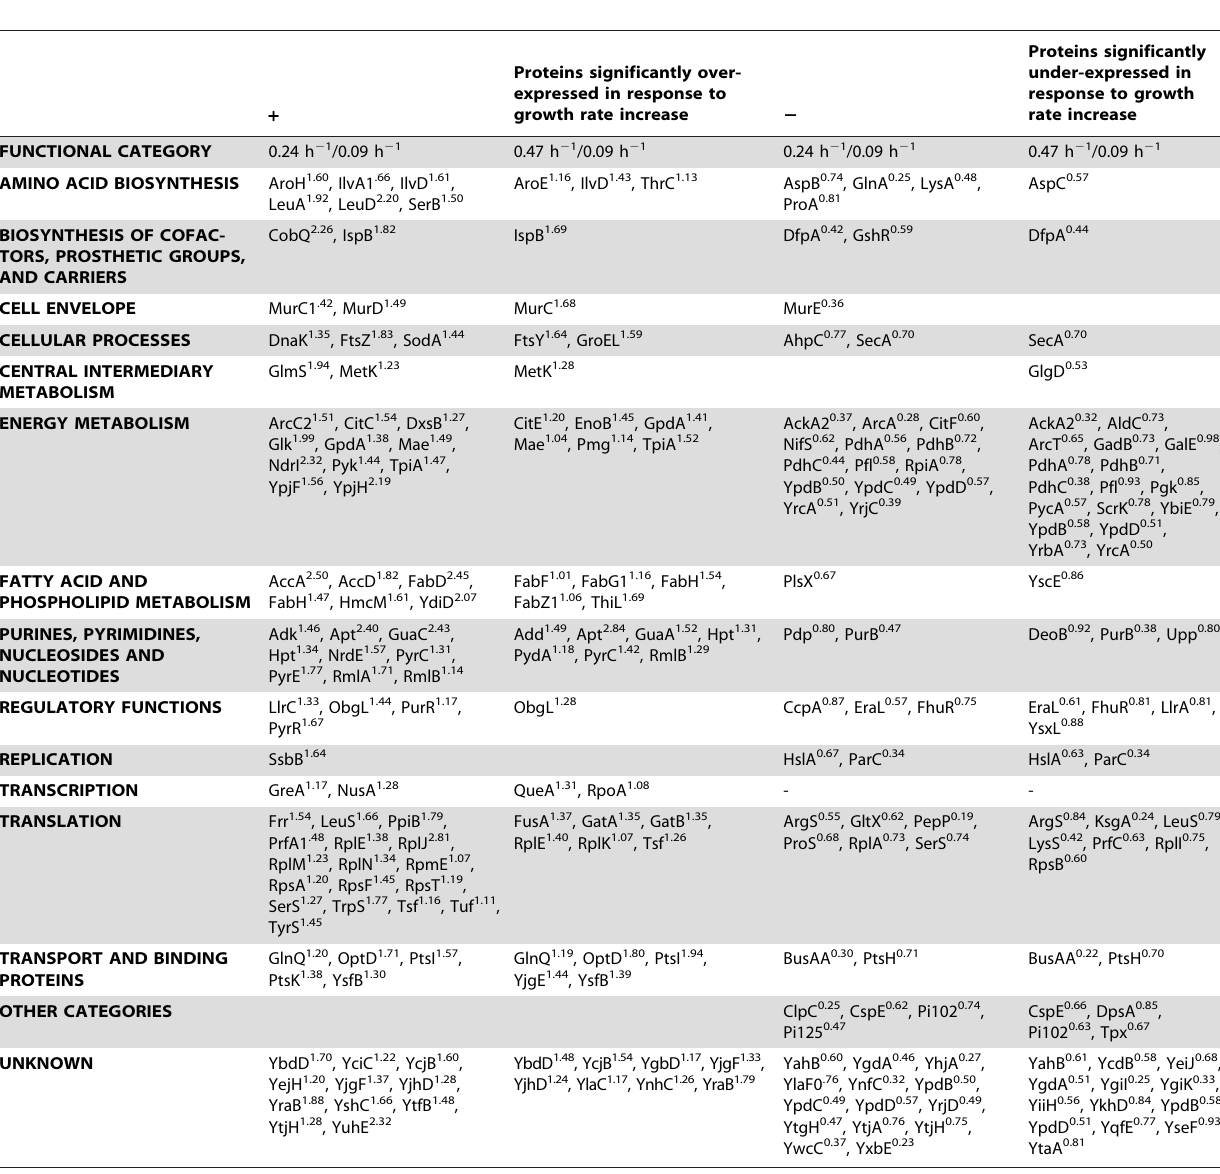
Table 1. List of proteins ordered by functional category and changing when growth rate increases from 0.09 to 0.24 and 0.47 h 2 1 during continuous culture of L. lactis